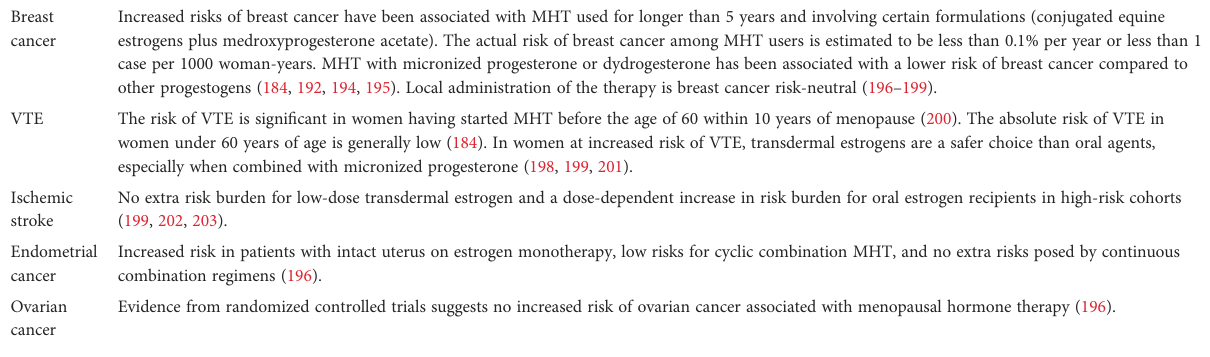
TABLE 4 Potential risks of MHT. Breast